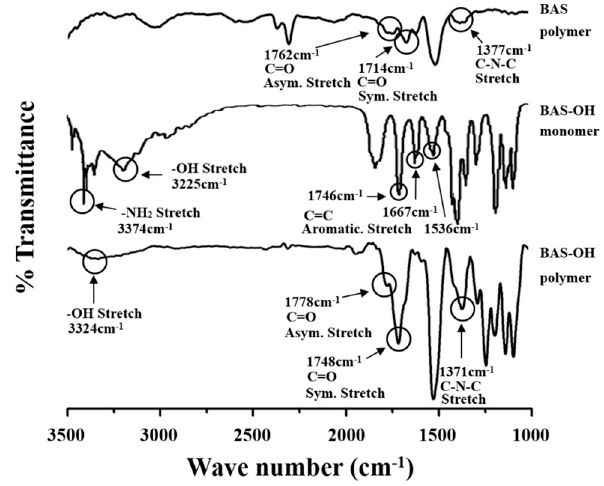
Figure 2. FT-IR spectra of monomer and PIs.